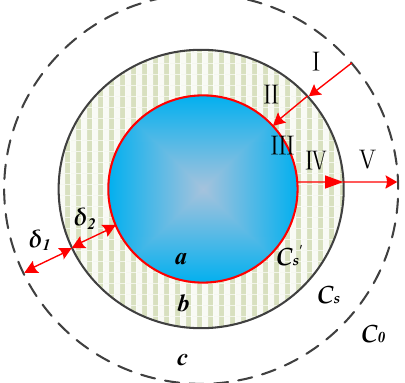
Figure 10. Illustrative diagram of shrinking unreacted core model.